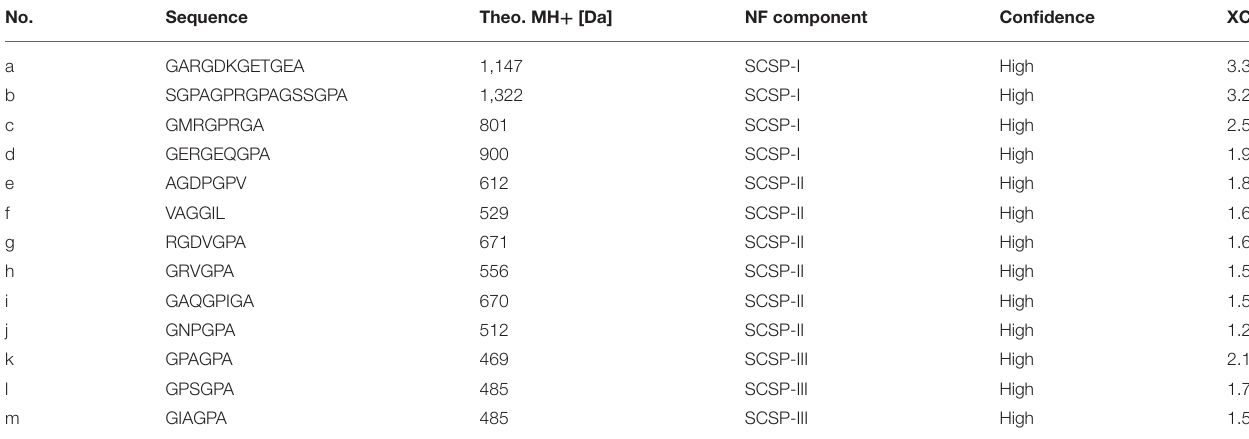
TABLE 1 | The peptide sequence and molecular weight of